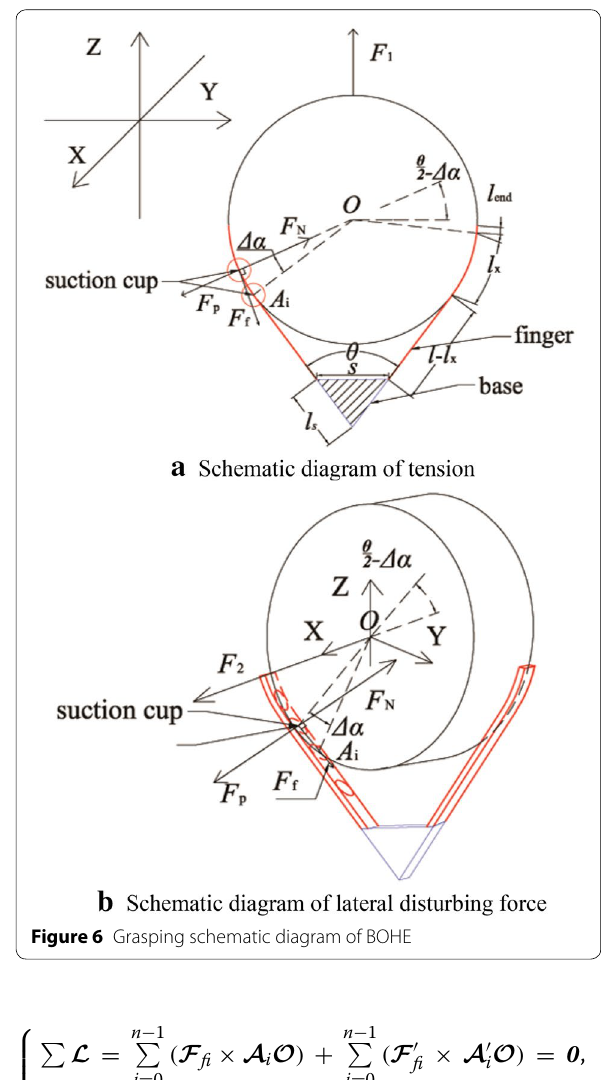
Figure 6 Grasping schematic diagram of